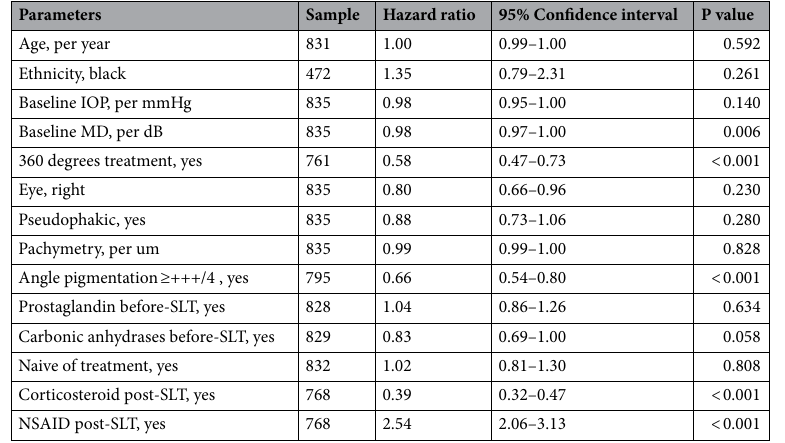
Table 4. Univariable analysis of factors associated with failure after selective laser trabeculoplasty treatment. IOP intraocular pressure, MD mean deviation, SLT selective laser trabeculoplasty, NSAID nonsteroidal anti- inflammatory drug.